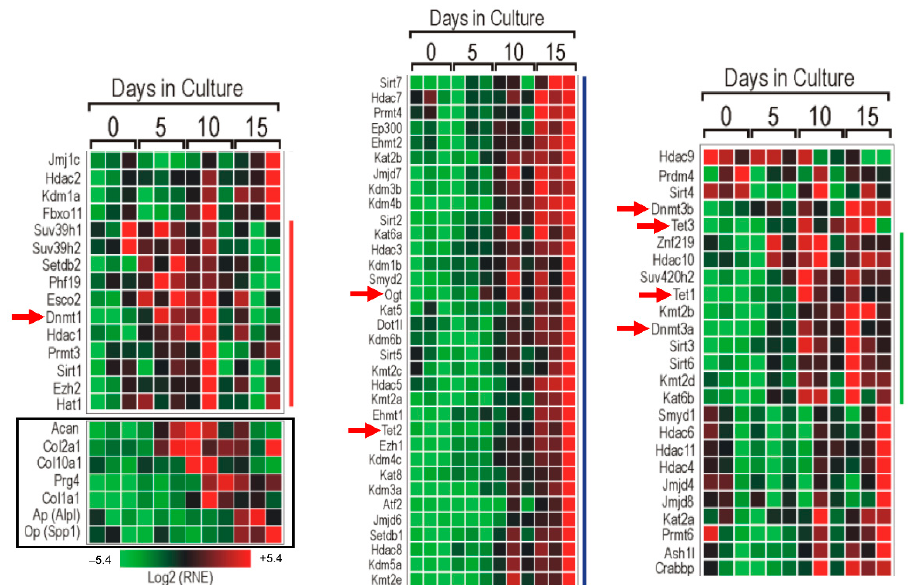
upregulated between the 5th and 10th days of culturing. Genes neighboring the blue line are upregu- lated around culturing day 15. Genes next to the green line are upregulated between the 10th and 15th days of culturing. Specific DNA methylation and demethylation regulator genes are marked with red arrows. Data indicated with the black rectangle: expressional changes of chondrogenic and osteogenic marker genes in order to verify the cartilaginous differentiation of micromass cultures.